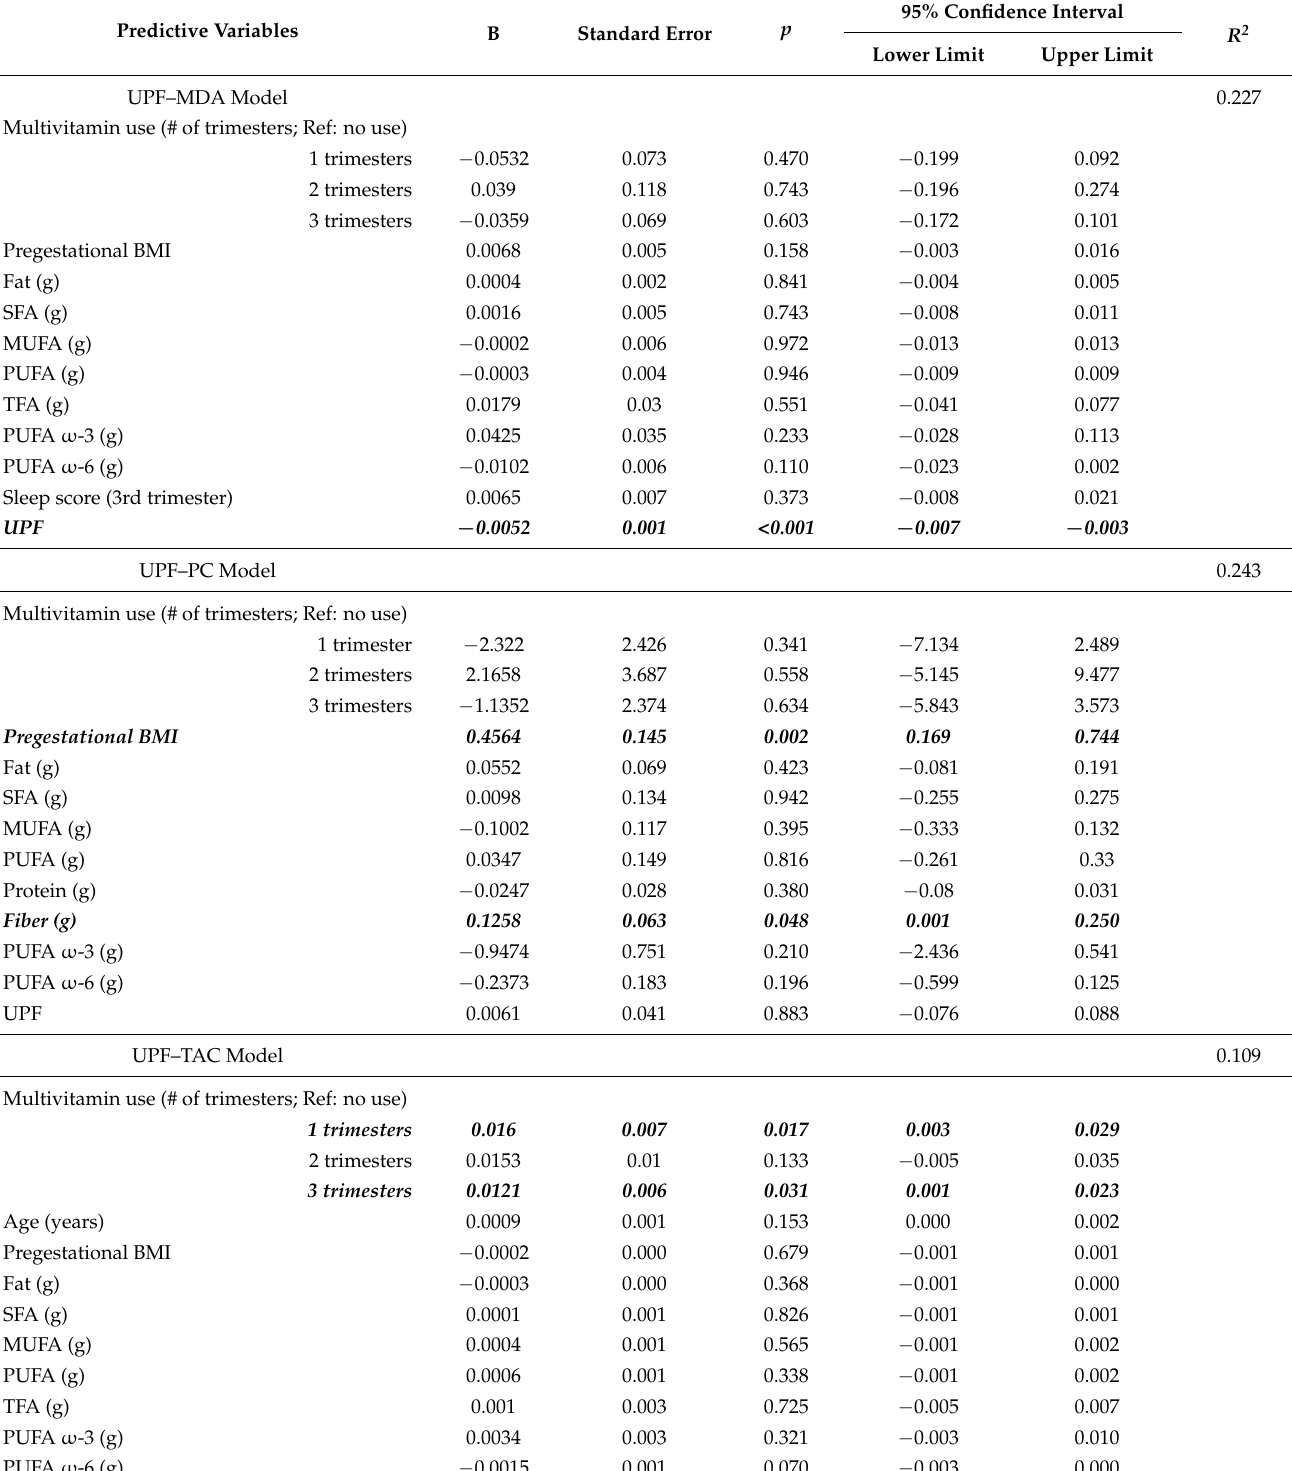
Table 4. Association of UPF consumption with OS